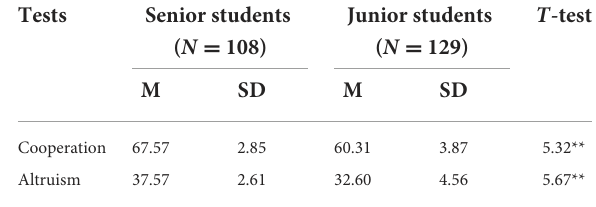
TABLE 4 Mean scores, standard deviations, and t -test values of seniors and juniors on the cooperation and altruism scale.